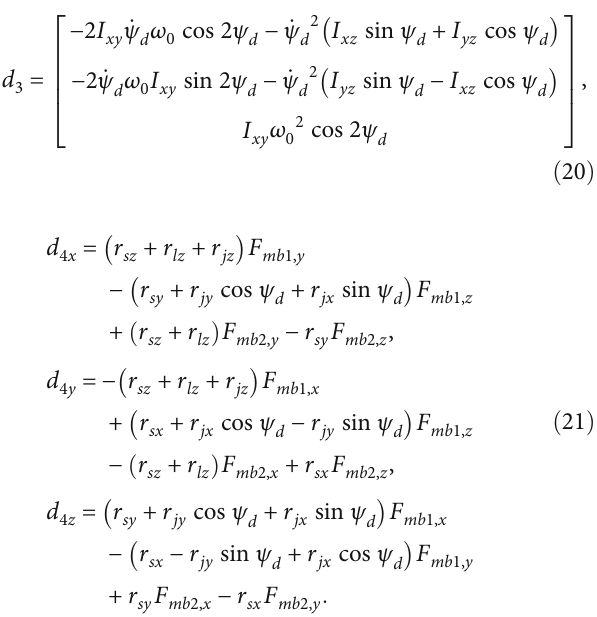
Table 1: Payload inertia parameter values for di ff erent